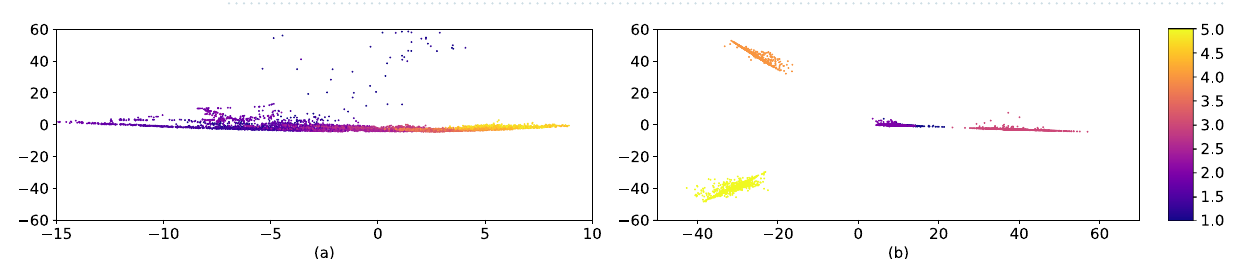
Table 2. Fine-grained estimation on PD-sEMG dataset. The best performance in each column is marked in bold.